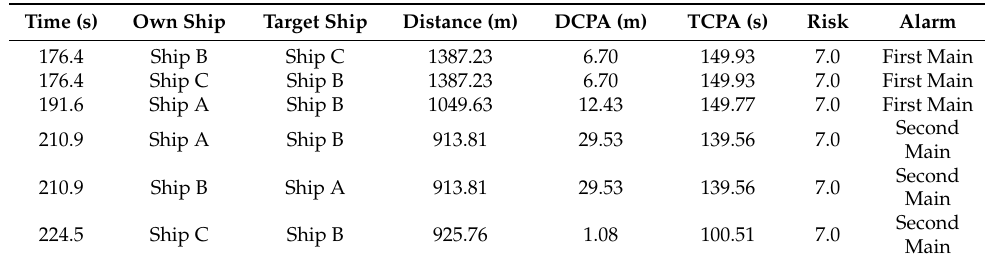
Figure 6. ( a ) Diagrammatic representation of the track of alarms generated from the test results of scenario 2 and ( b ) graphical representation of the alarms generated on ship C depending on the time (from the top, alarms based only on DCPA and TCPA criteria, alarms based only on PARK model risk value criterion, and the alarms based on the algorithm). Table 4. Analysis of the situation when the first alarm was generated on each ship from the test results of scenario 2.